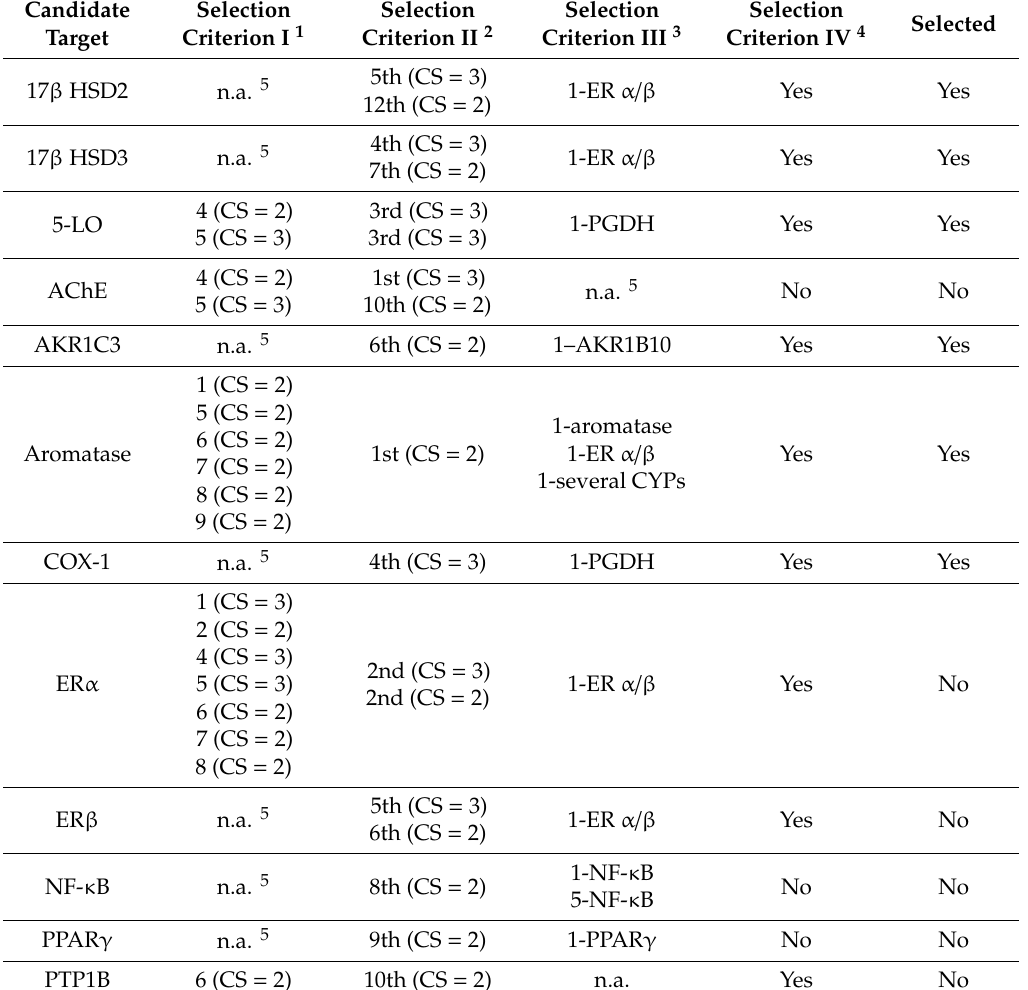
Table 2. Twelve frequently predicted targets for DHC chemical space assessed according to selection criteria I–IV and a final selection